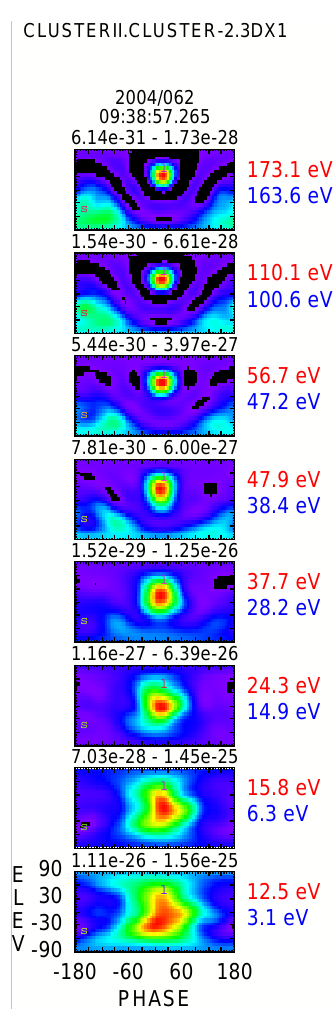
Fig. 1. An example set of PT plots from a typical foreshock eVDF showing the electron core, halo, strahl and return populations. The solid circle and triangle are projections of the magnetic field. Field aligned strahl and return populations (upper 2 plots) are centered on the field projections while the halo and core moving radially outward from the sun are centered in the plot itself. Data is plotted in units of (s 3 cm − 6 ). Red energy labels are the center energy used for each PT plot while corresponding blue labels are the potential corrected